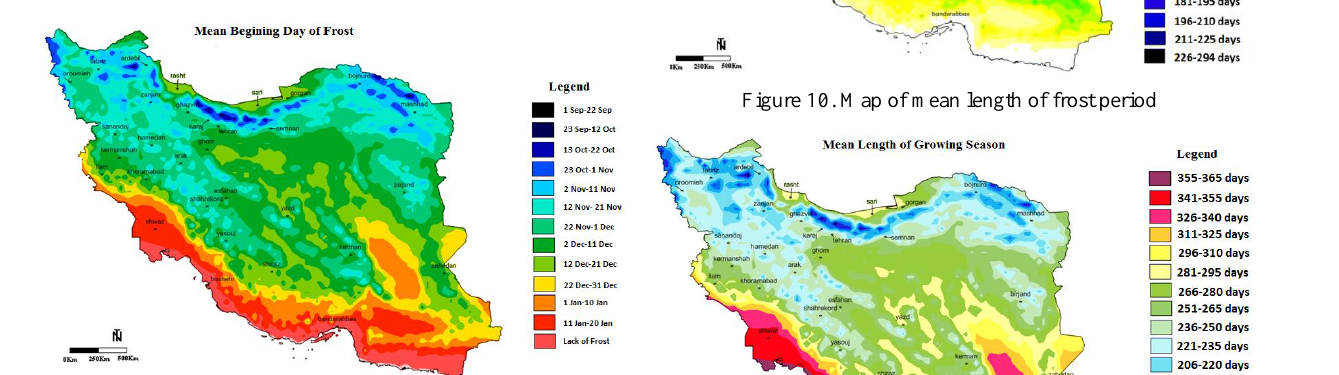
Figure 7: Map of mean Julian day of the first frost in Iran